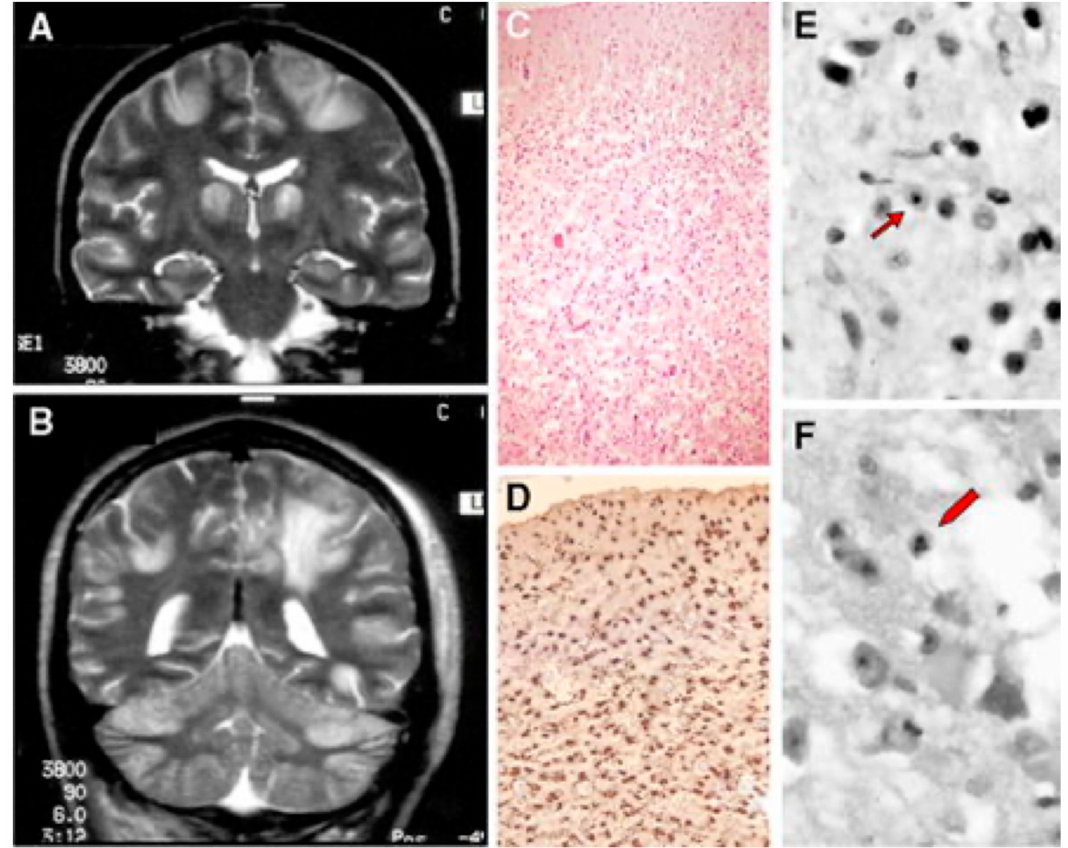
Figure 4. A patient affected with Alpers–Huttenlocher (AHS) disease. ( A , B ) Head MRI scan (coronal plane, T2 weighed images). Bilateral focal hyperintensities are seen of the hemispheric cortex and thalami ( A ), of the white matter and cerebellar cortex ( B ). ( C – F ) Histological sections through cortical lesions of the same patient (HE stain; C, E, F, and GFAP; D). The pattern of the necrotizing lesions of the cortex is shown with microcavitation, vessel proliferation, neuronal loss ( C ), and the associated gliosis ( D ). Features of cell death: acute ischemic changes (arrow; E ) and nuclear fragmentation (arrowhead; F ) of two cortical neurons. Adapted from